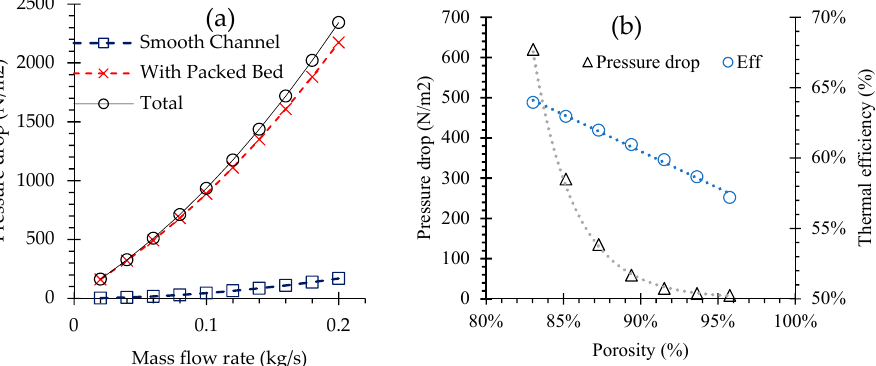
Figure 8. ( a ) Pressure drop against mass flow rate and ( b ) variation in thermal efficiency against the mass flow rate with different porosity values.